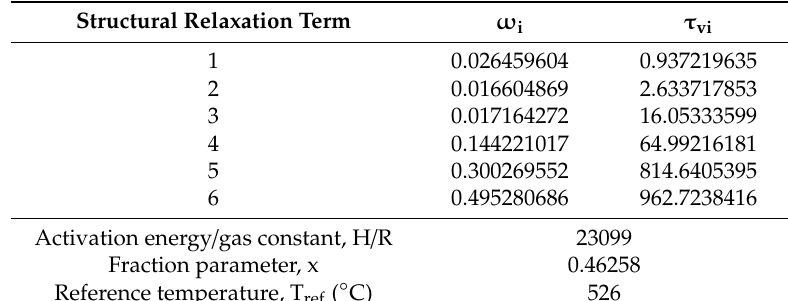
Table 4. Structural relaxation properties of D-ZK3L.